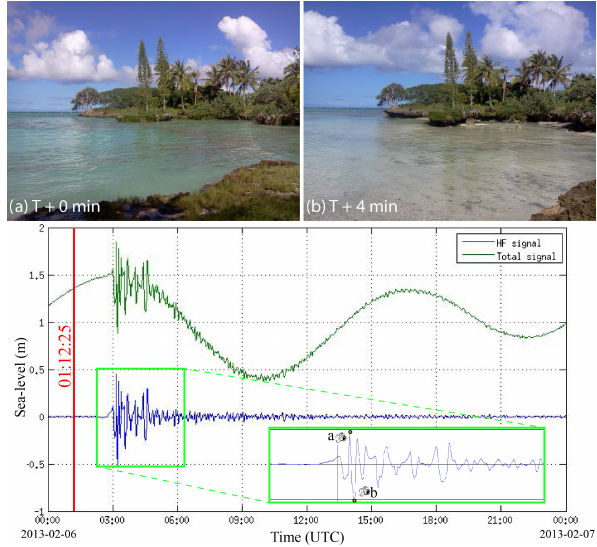
Figure 6. The 6 February 2013 Solomon Islands tsunami record from Lifou tide gauge (green: raw signal; blue: filtered). The red line locates the earthquake time. The two pictures were taken at Mou (on the southeastern coast of Lifou) at the maximum (a) and min- imum (b) sea levels. The green inset focuses on the main tsunami signal (photos courtesy of Matthieu Le